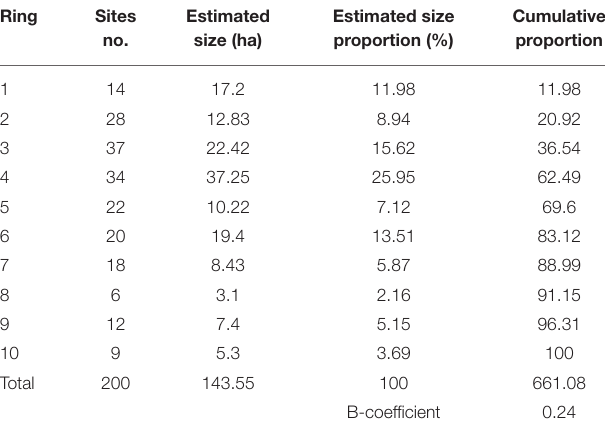
TABLE 11 | Calculation of B-coefficient for Tuscania in the Iron Age/Orientalizing period. Ring Sites Estimated Estimated size no. size (ha) proportion (%)